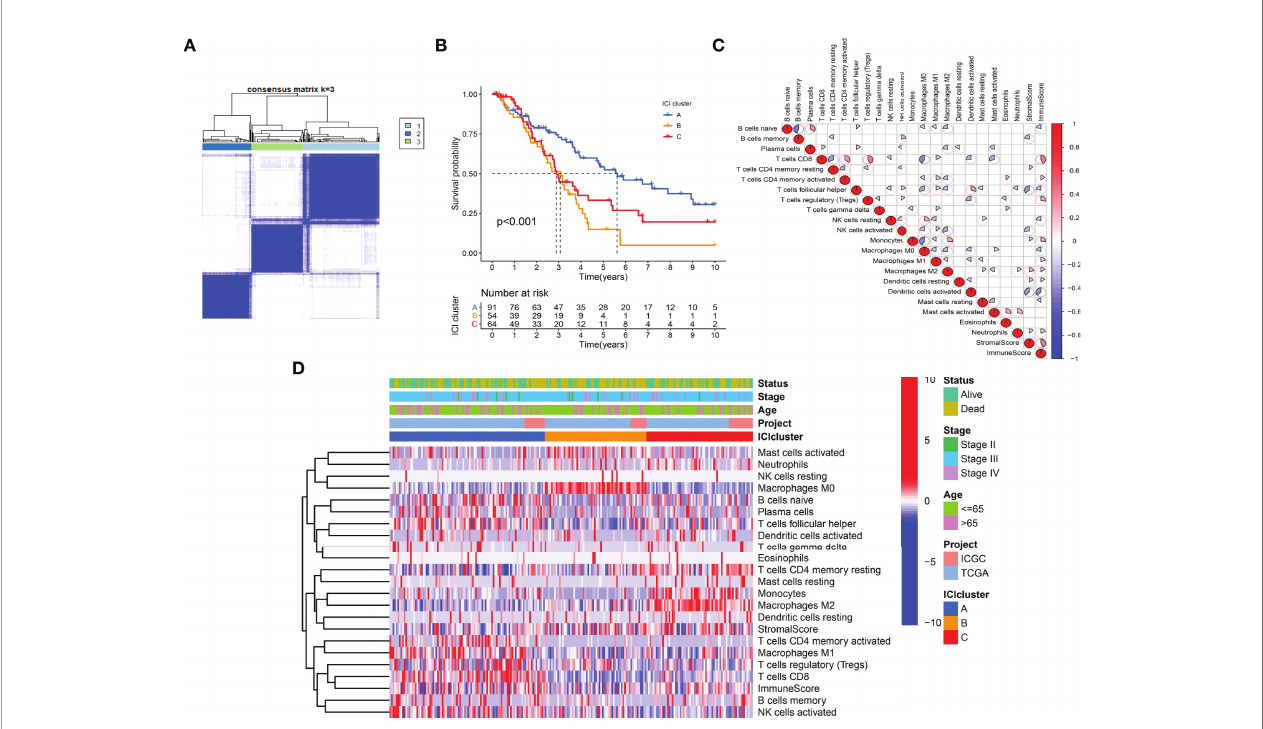
FIGURE 2 | Immunotypes and immune cell in fi ltration (ICI) landscape of OC. (A) ICI subtypes identi fi ed with ConsensusClusterPlus. (B) Kaplan-Meier curves of ICI subtypes with log-rank test P < 0.001. (C) Heatmap of Pearson correlation coef fi cients among immune cells. (D) Characteristics of ICI levels and clinical features in ICI